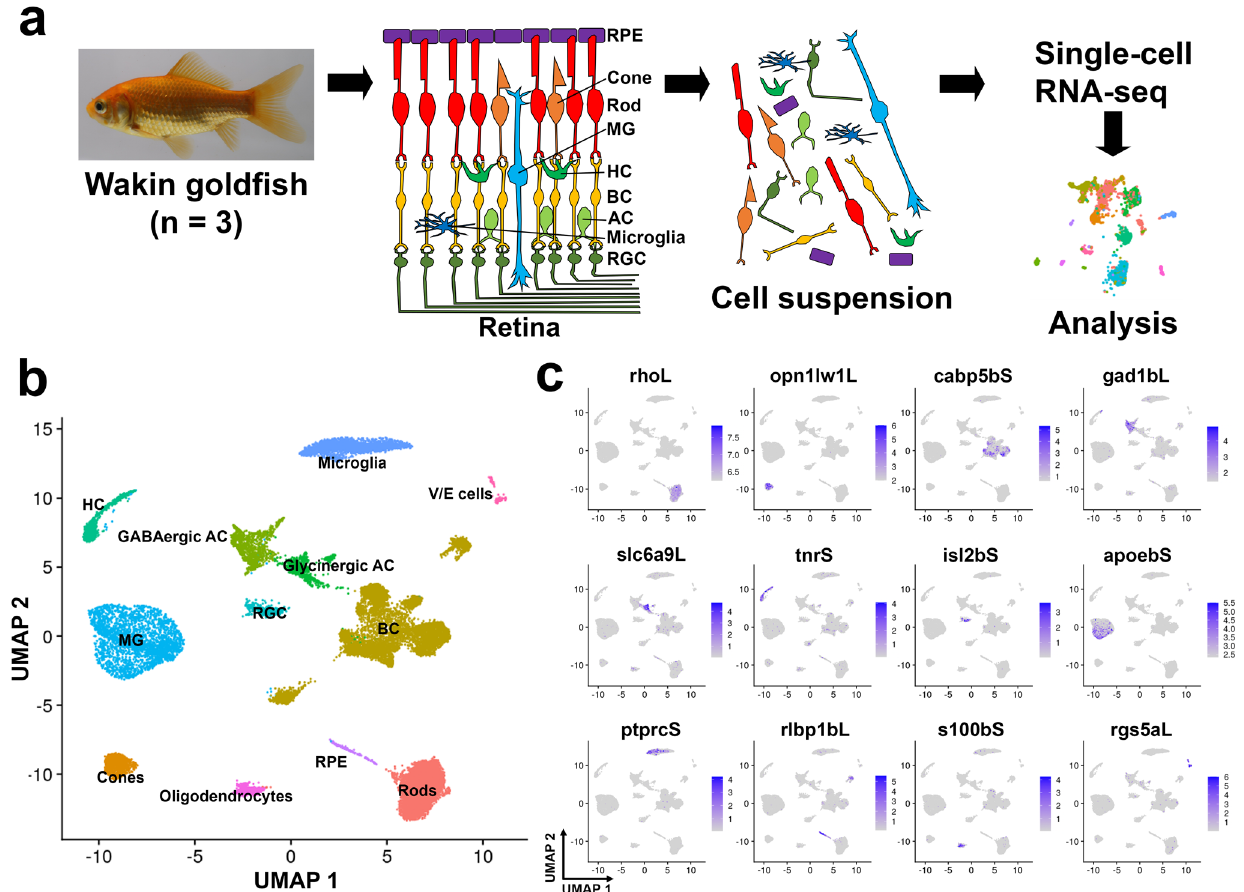
Fig. 1 scRNA-seq analysis of the Wakin gold fi sh retina. a The retinas from three Wakin gold fi sh individuals were enzymatically dissociated, and single cells were isolated, followed by scRNA-seq library preparation. The photo was taken by the authors. All fi gures were produced by the authors. b UMAP plot showing the cellular composition of the retina from Wakin gold fi sh ( n = 3 biologically independent samples). The 22,725 cells were projected into a two- dimensional space by UMAP. The cells were classi fi ed into 12 cell types. c The expression of the cell-type-speci fi c marker genes in the 12 gold fi sh retinal cell types is shown. RPE retinal pigmented epithelial cells, RGC retinal ganglion cells, HC horizontal cells, AC amacrine cells, BC bipolar cells, MG Müller glia, V/E cells vascular endothelial